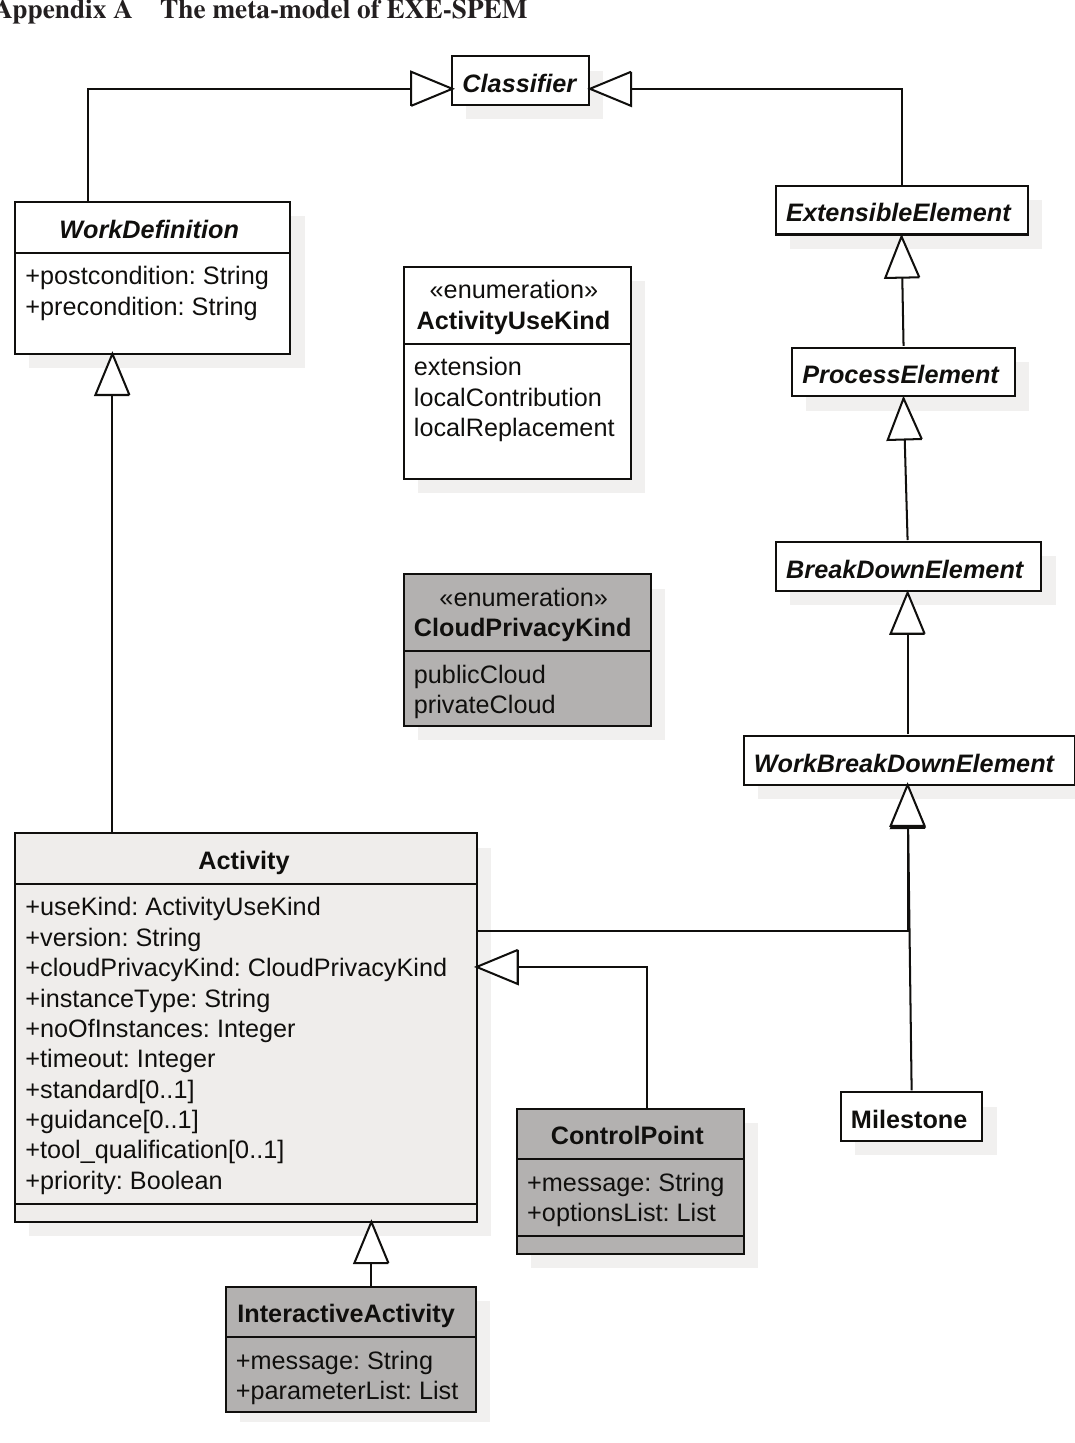
Figure A.1: The meta-model of